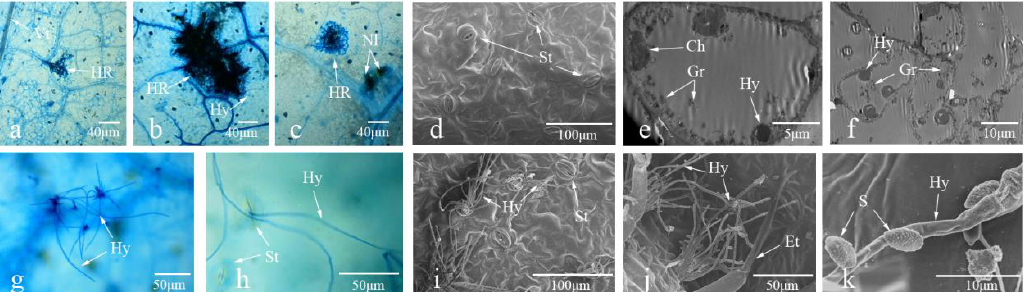
Figure 2. Optical microscopy, scanning electron microscopy, and transmission electron microscopy images of tomato leaf samples. ( a – c ): Ont7813 leaf stained with lactophenol trypan blue at 9, 15, and 21 dai, as seen under an optical microscope. ( d – f ): Ont7813 leaf at 9, 15, and 21 dai under an electron microscope. ( g , h ): MM leaves stained with lactophenol trypan blue at 9 and 15 dai, as seen under an optical microscope. ( i – k ): MM leaf at 9, 15, and 21 dai under an electron microscope. Hy: hypha; Nl: necrotic lesion; S: spore; St: stoma; Et: epidermal trichome; Ch: chloroplast; Gr: granum.